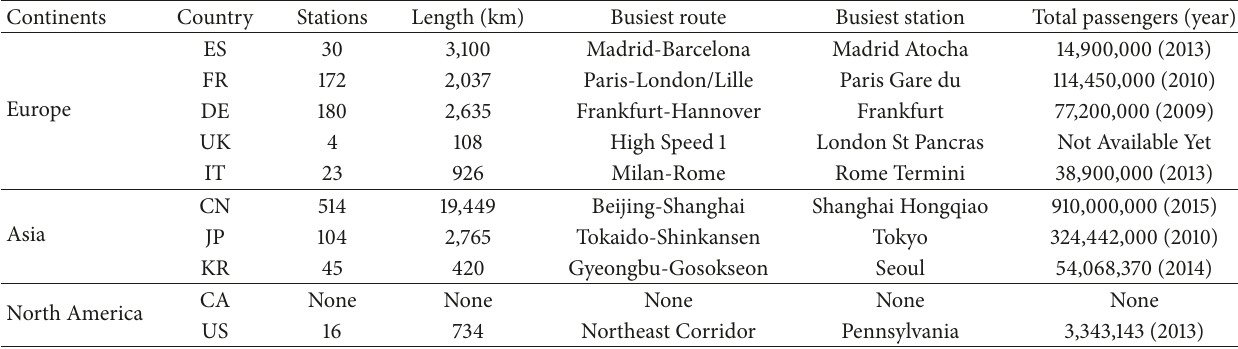
Table 2: Overview of the HSR in five countries in Europe, three countries in Asia, and two countries in North America. Note that we use the latest data which is available. Data source: collected by hand from public accessible web pages. Continents Country